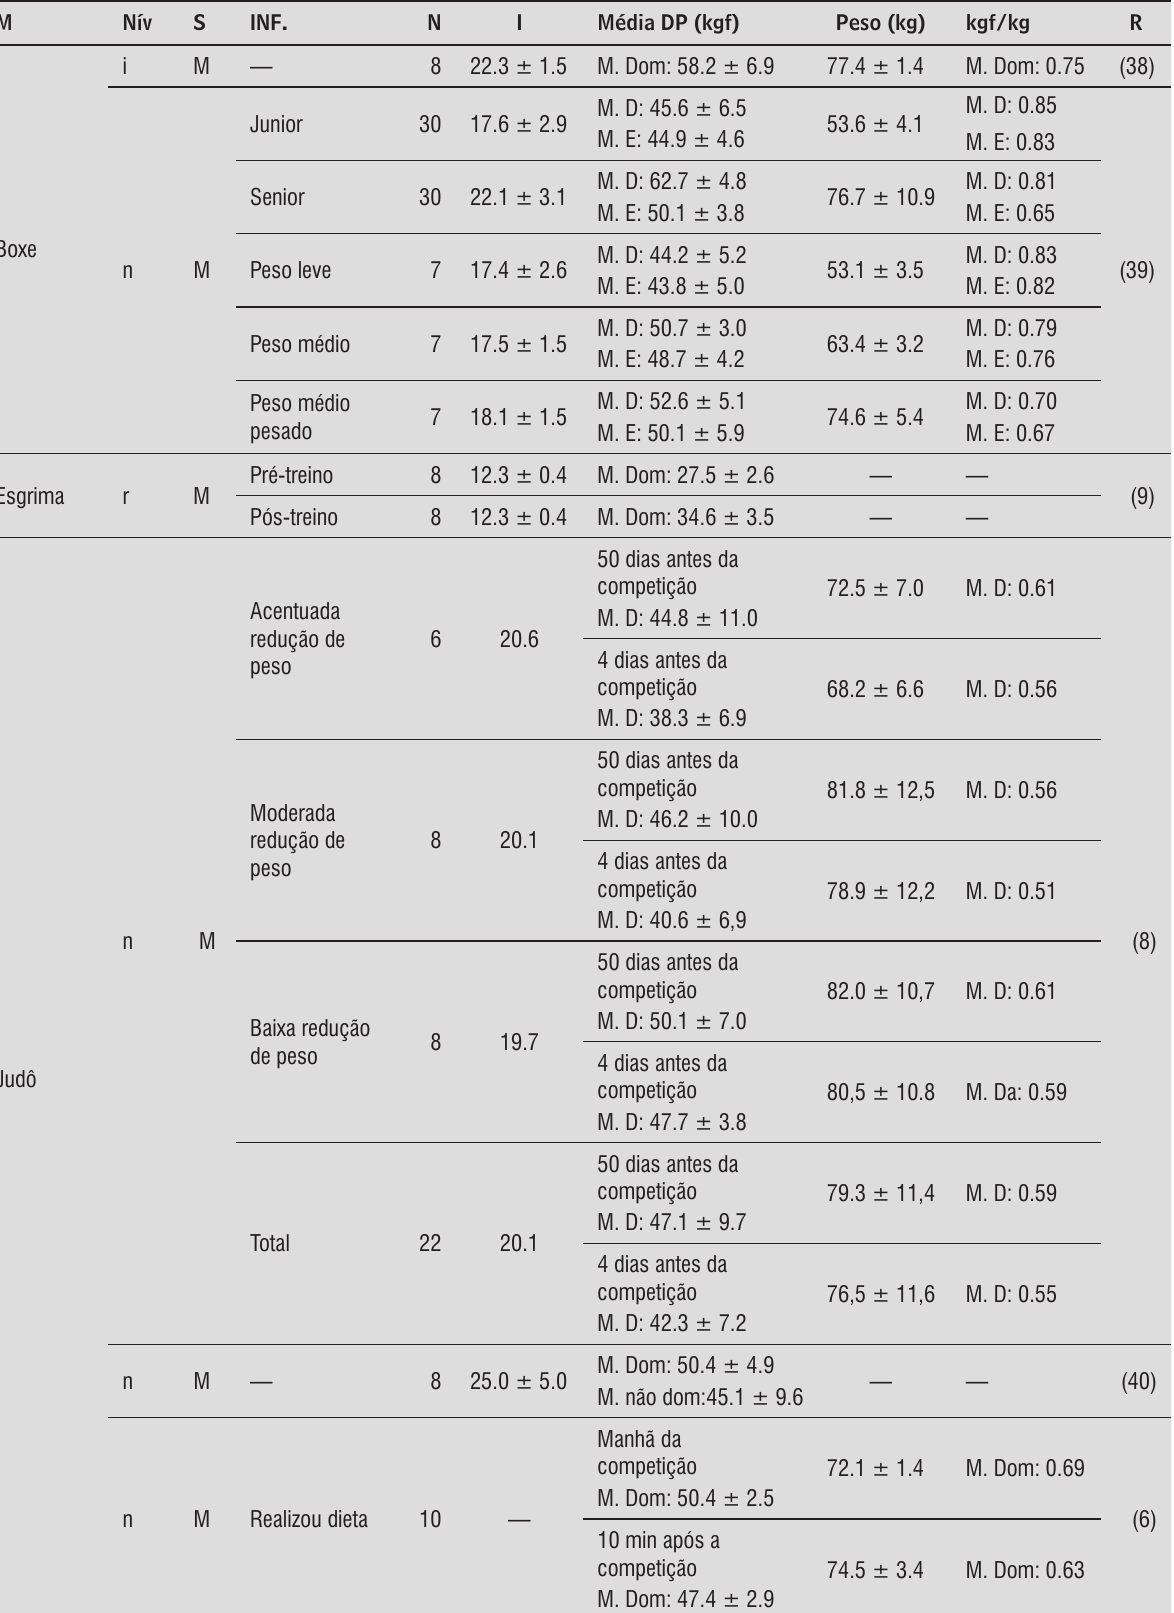
Tabela 1 - Valores da força de preensão manual em diferentes tipos de lutas